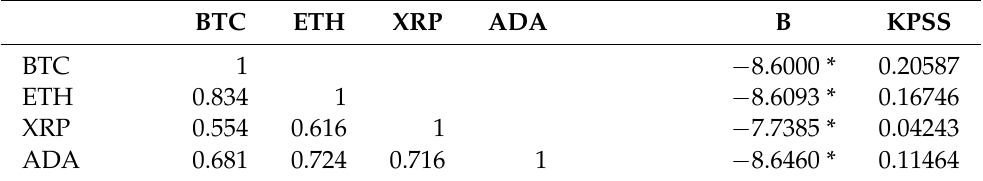
Table 2. Correlation and Unit Root Test—Cryptocurrencies.